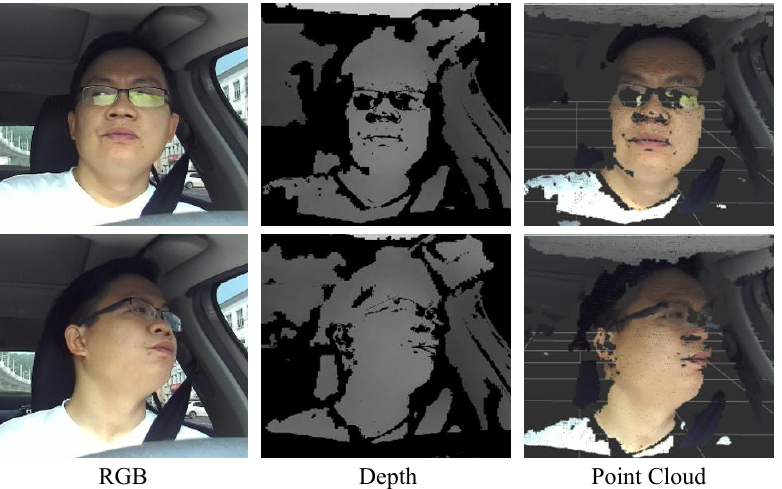
Figure 1. Challenges in the naturalistic driving